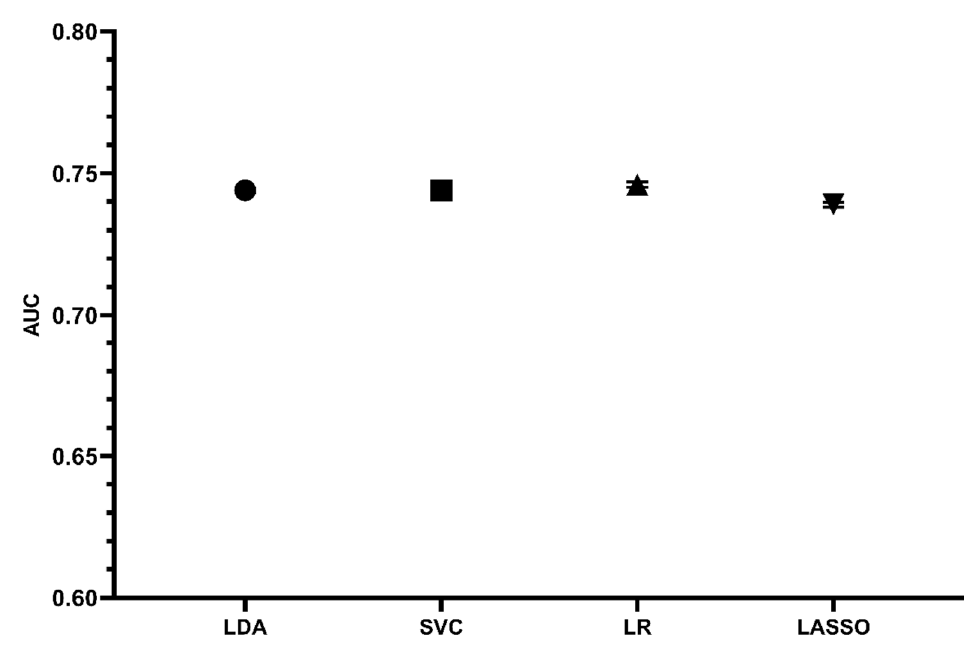
Figure 11. AUCs of nomogram and ML prediction models in testing cohort.